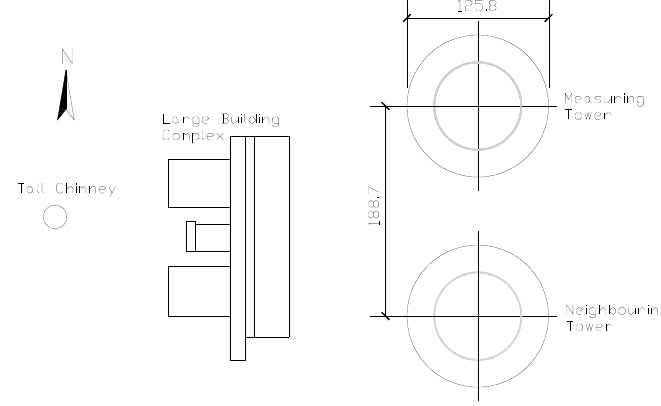
Figure 2. Site plan of Peng-cheng electric power station (unit: m).